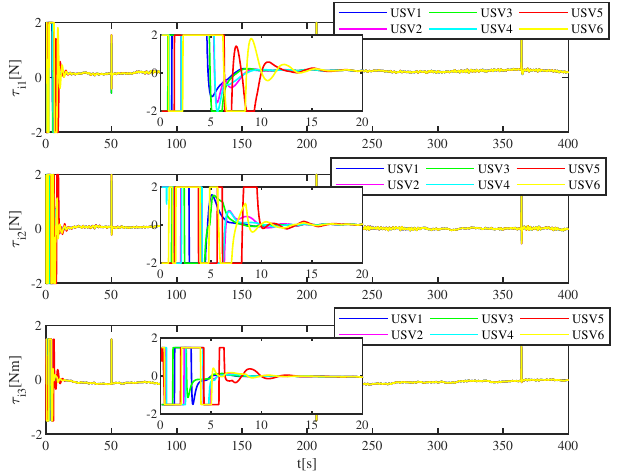
Figure 10. Control input of six USVs using NADSC without ADS.